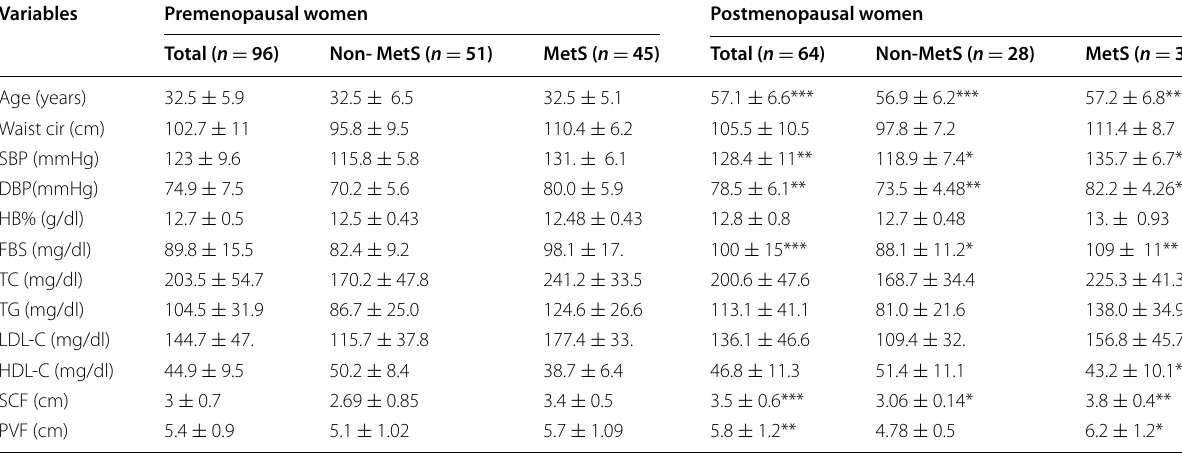
Table 1 Baseline characteristics, biochemical and abdominal fat of premenopausal, and postmenopausal women stratified for having or not the metabolic